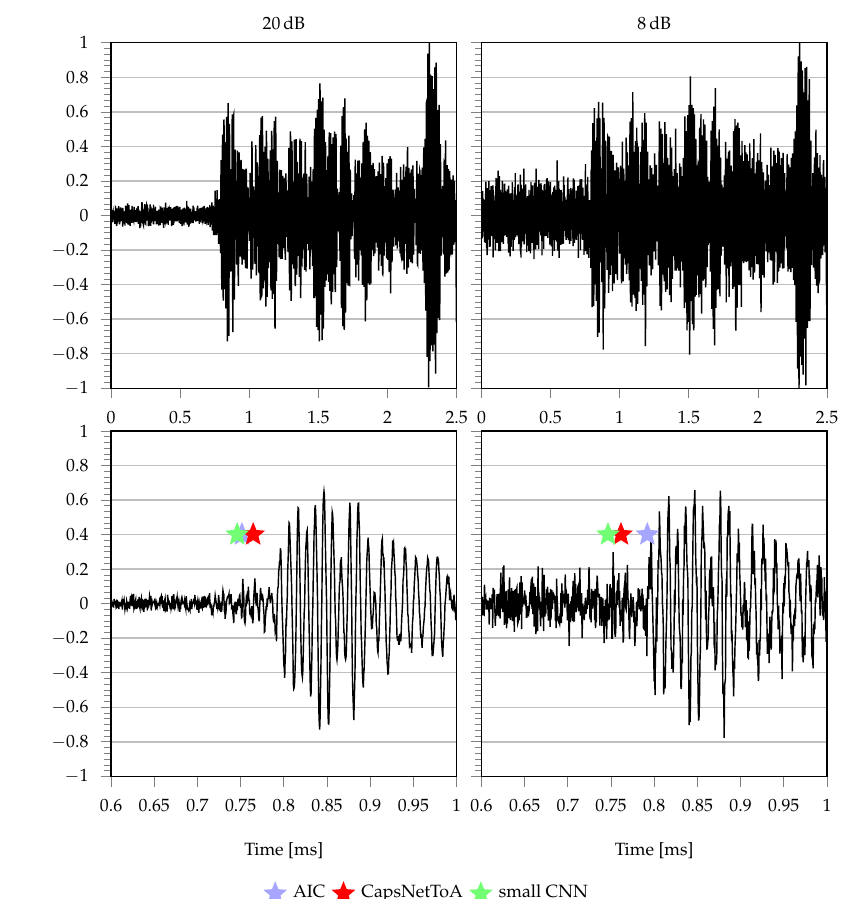
Figure 12. ToA predictions for AIC (blue), CapsNetToA (red) and small CNN (green) for excitation point 5: ( left column ) SNR = 20dB and ( right column ) SNR = 8dB, with second row depicting a magnified region of the time interval where ToA is